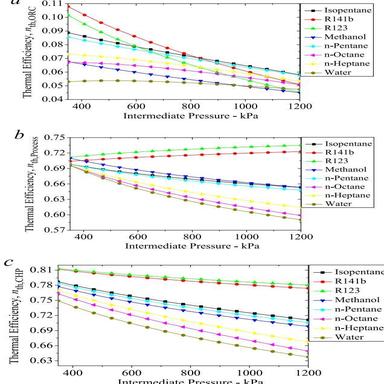
Thermal efficiencies as a function of intermediate pressure ORC (a) Process (b) CHP (c).